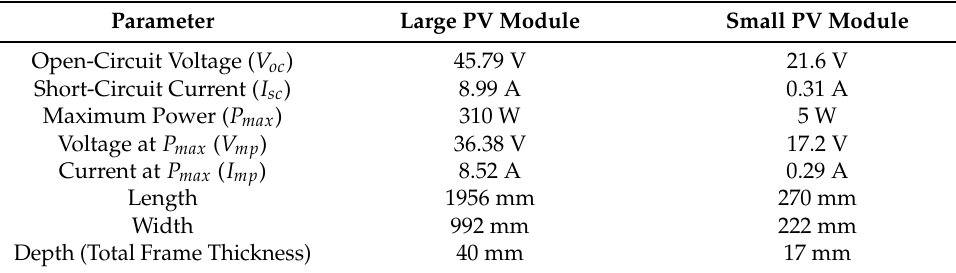
Figure 8. The large ( left ) and the small ( right ) PV modules. Table 1. Datasheet parameters for the large and small PV